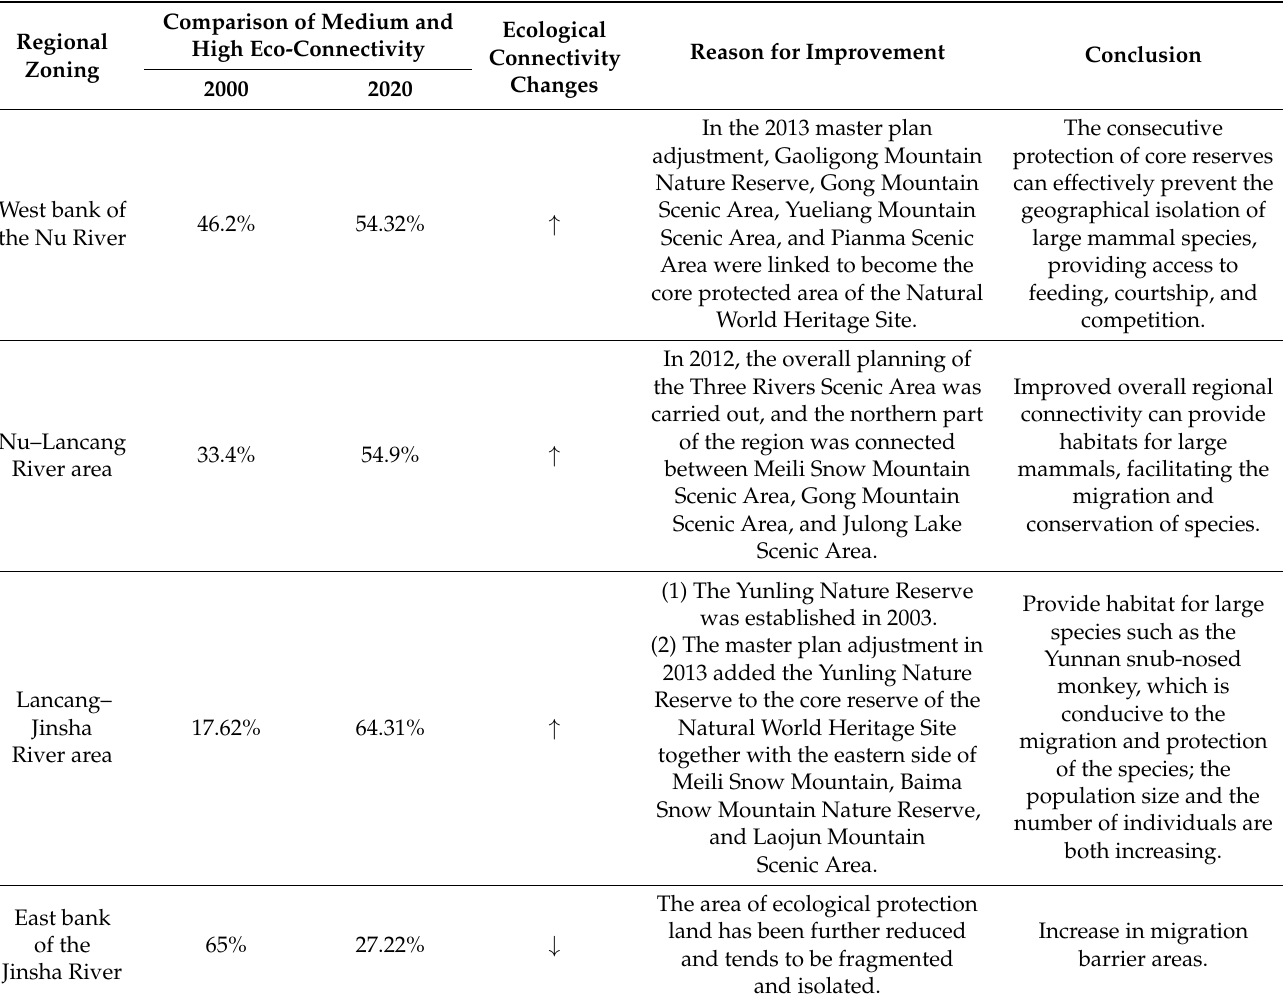
Table 9. Reasons for the improvement of ecological connectivity in the subregion and related